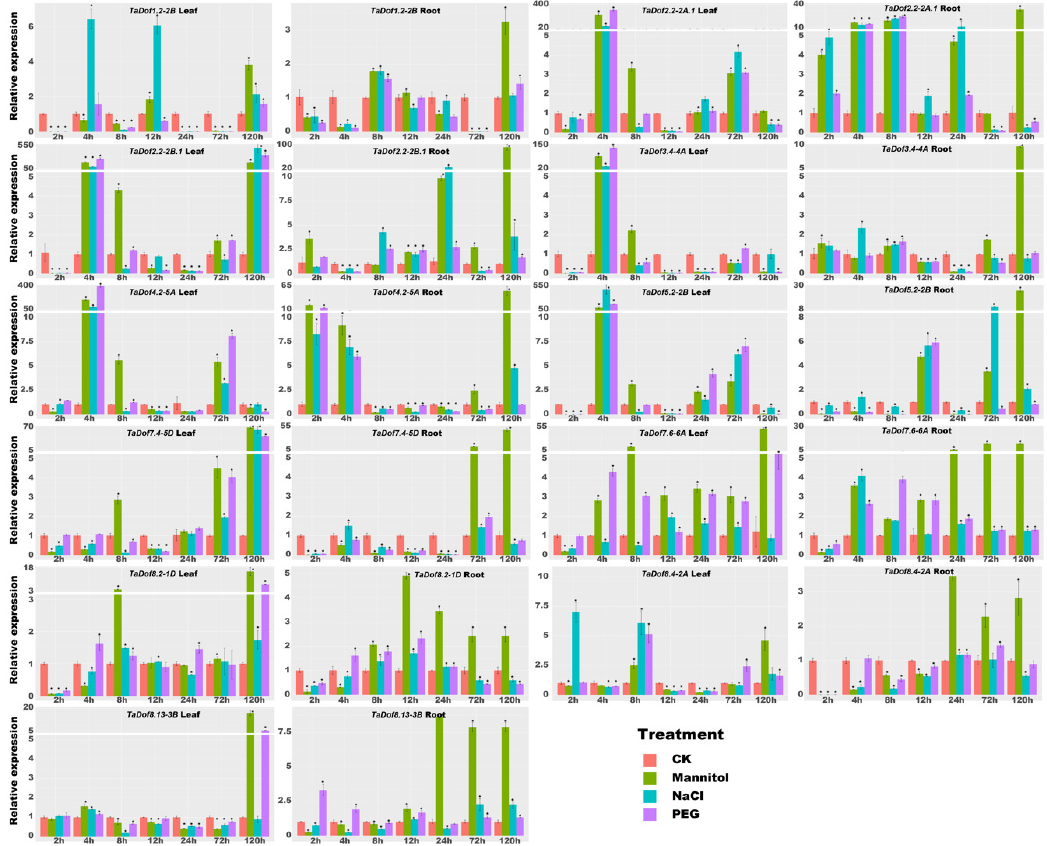
Figure 8. The qRT-PCR results. t -tests were used to determine significant differences in expression patterns for CK versus mannitol, NaCl and PEG treatments (*, p < 0.05). patterns for CK versus mannitol, NaCl and PEG treatments (*, p